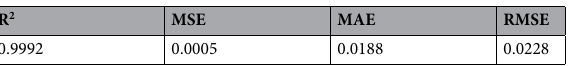
Table 6. Performance evaluation matrices for electric field prediction